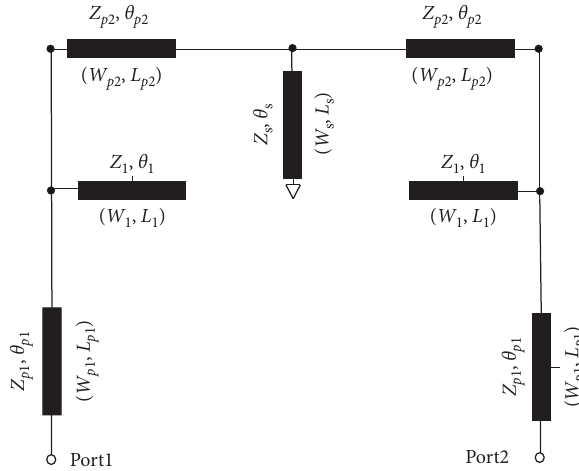
Figure 4: *e based tri-band equivalent transmission line model for the proposed BPF.